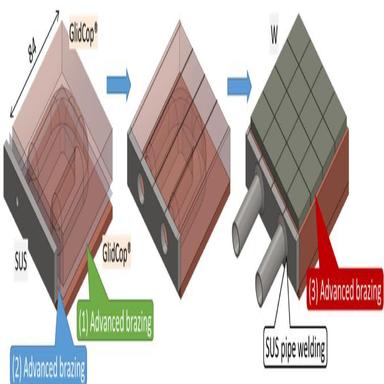
Possible example of the AMSB process for fabricating the divertor mock-up.